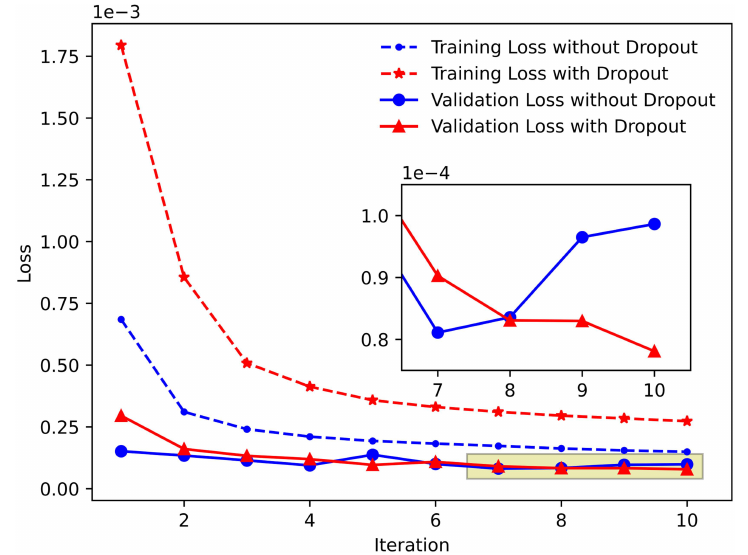
Figure 7. Loss function values of CDAEs and